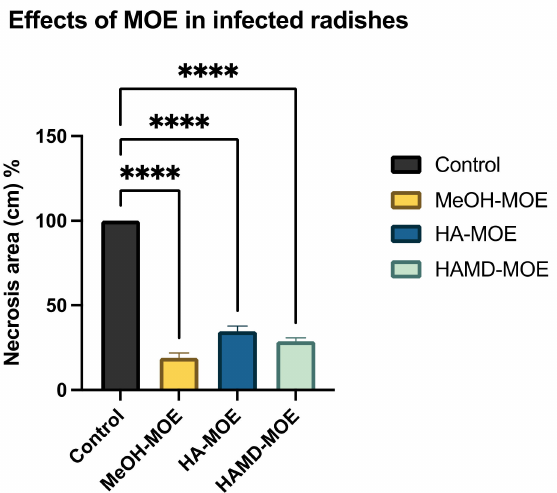
Figure 6. Effects of MOEs in infected radishes. The Xcc infection in radishes was measured by ImageJ quantification of the necrotic area and presented as the percentage compared to the control. Data are the mean of 3 independent experiments performed on triplicate (mean +/ − standard deviation), and values are represented as a percentage; **** p -values <